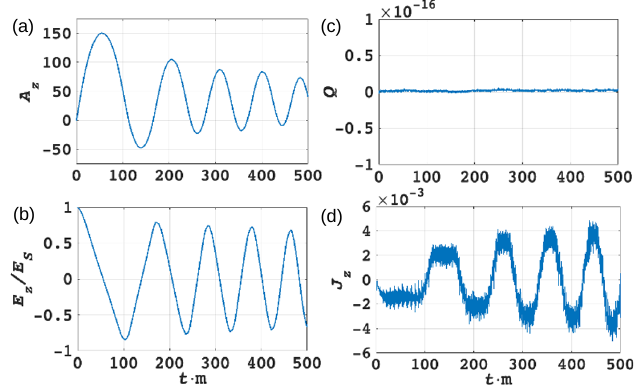
Figure 7 . Dynamical properties of U(1) gauge field and fermions. (a)-(b) Numerical evolution of gauge connection A z and associated electric field E z (normalized by E S ). The chirped electric field exhibits dissipative anharmonic feature, which can be used as a probe to diagnose the state of e - e + pair oscillators. In this simulation ( t ∼ 500 /m ), the electric field amplitude approaches 0.68 E S , which means that more than half of the gauge field energy has been consumed to create e - e + pairs. All QED phenomena admit the charge conservation law, which means that the net charge Q in Schwinger process must keep 0. It can be found in subfigure (c), where a numerical noise induced extremely small net charge is well conserved in the simulation. (d) shows the pair plasma oscillation induced ensemble current density. With the nonlinear increase of fermion density, The current amplitude experienced a growth process with a decay rate. Obviously, the chirped oscillations of current and elctric field are well matched with a π/ 2 phase difference. ( e/m = 0 . 2 , ∆ x i = 0 . 05 /m, ∆ t = 0 . 5∆ x i , N t = 2 × 10 4 , N x = N y = 1 , N z = 256 , N e = 512 ).